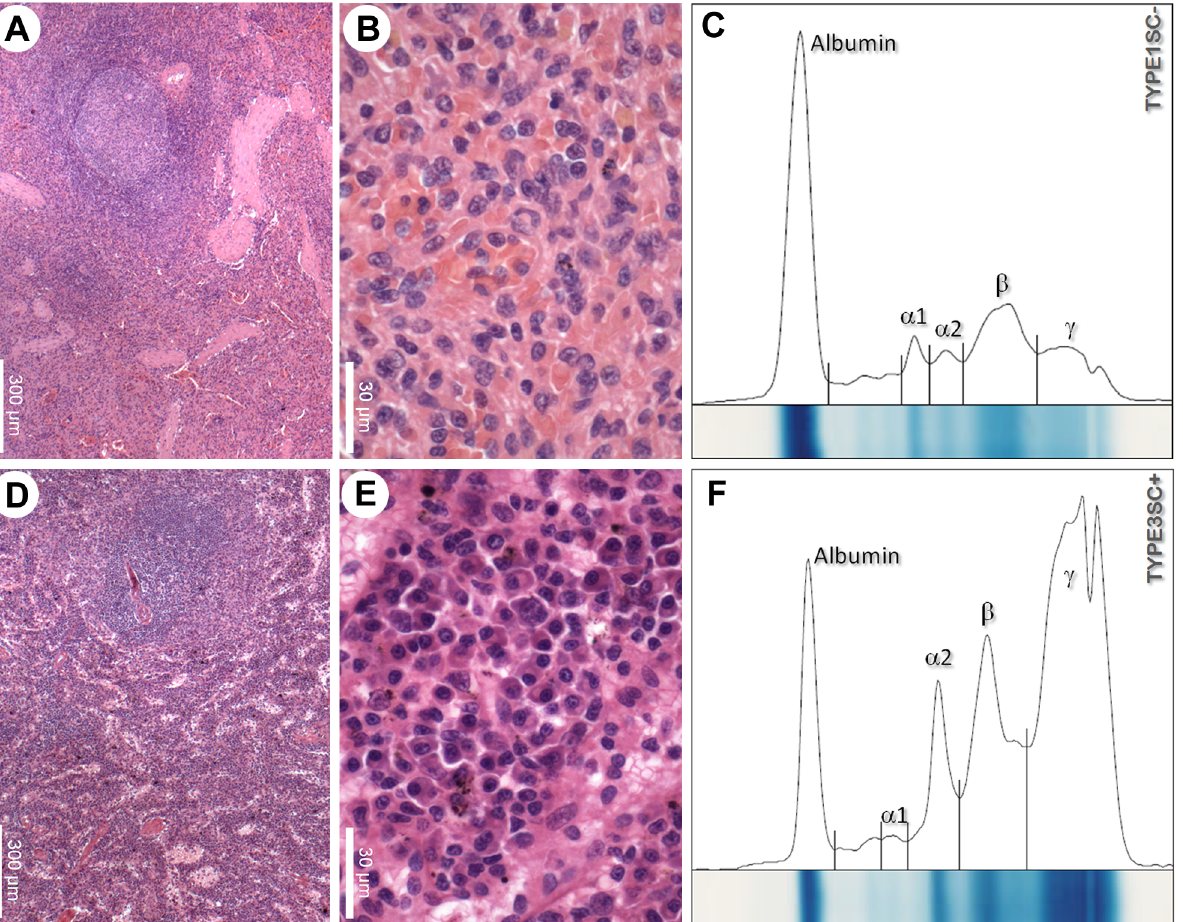
Fig 1. Plasmacytosis and dysproteinemia in dogs with visceral leishmaniasis and disruption of splenic white pulp. A-B – normal spleen of control TYPE1SC- animals. A — well-organized white pulp with secondary lymphoid follicles and distinct marginal and periarteriolar zones. B – red pulp with varied cell populations. C – normal pattern of serum protein distribution in electrophoresis. D-E – spleen with white pulp disruption in TYPE3SC+ animals. D – barely evident primary lymphoid follicle and inconspicuous marginal zone. E – red pulp plasmacytosis and (F) serum protein electrophoresis with a polyclonal pattern of gamma globulin